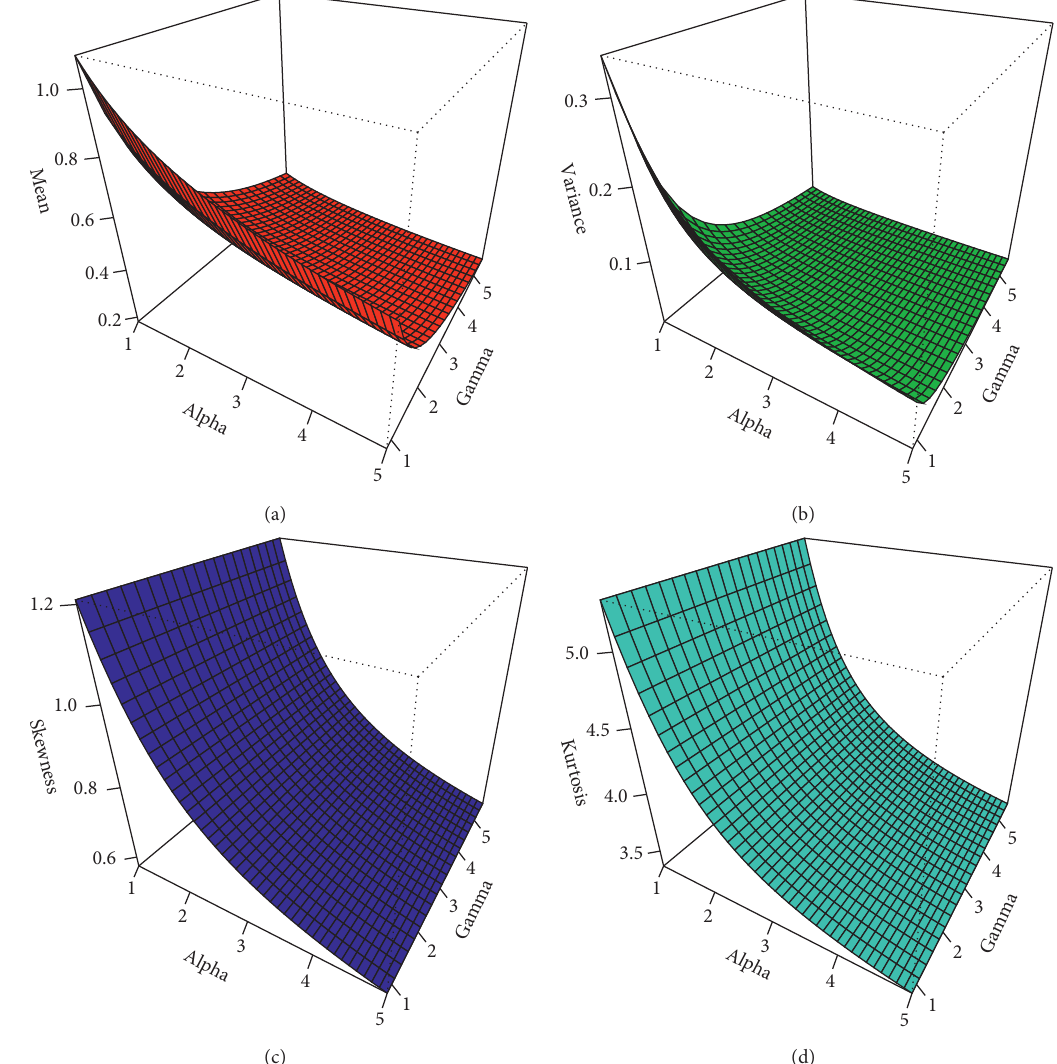
Figure 6: Plots for the mean, variance, skewness, and kurtosis of the L-Claim distribution for c � 1 and different values of α and σ